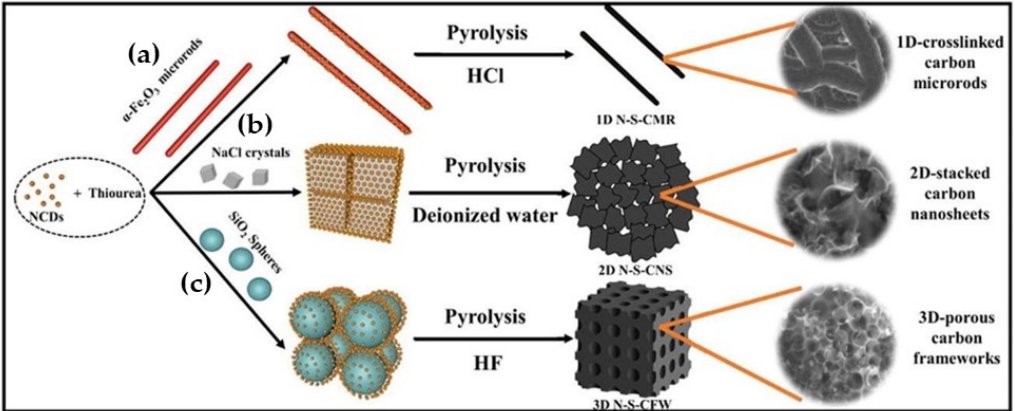
Figure 8. A schematic illustration of the template-assisted conversion of CDs into N- and S-doped ( a ) 1-D microrods, ( b ) 2-D carbon sheets and ( c ) 3-D PCFs (reproduced with permission from [127], 2021 Elsevier B.V) .